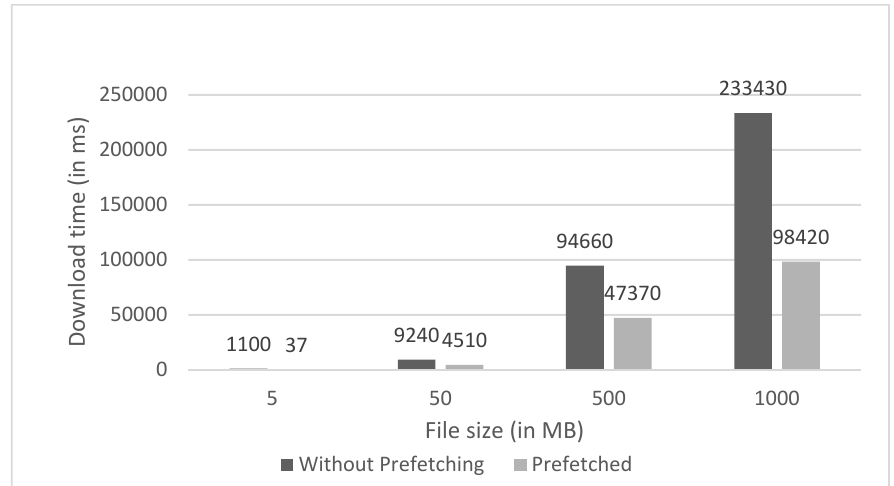
Figure 11. Average download times (in ms) of health record resources with various sizes (5 MB, 50 MB, 500 MB, and 1 GB) when the storage cloud and the prefetch engine were deployed in the same node (i.e., VM).